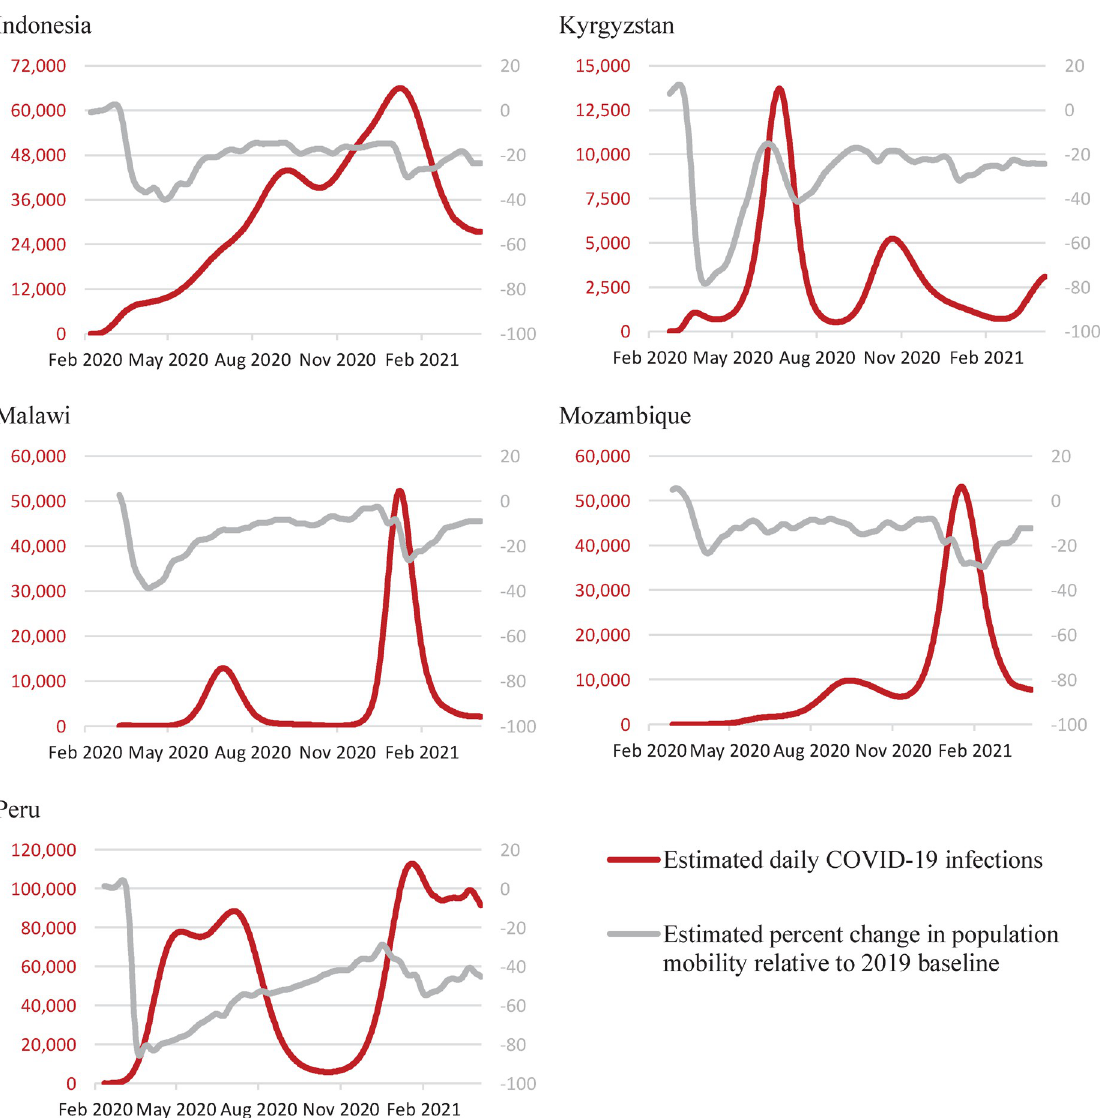
Fig 1. Estimated daily COVID-19 infections for the study period reported by IHME based on reported COVID-19 daily cases, tests, and Google mobility data from 9 April